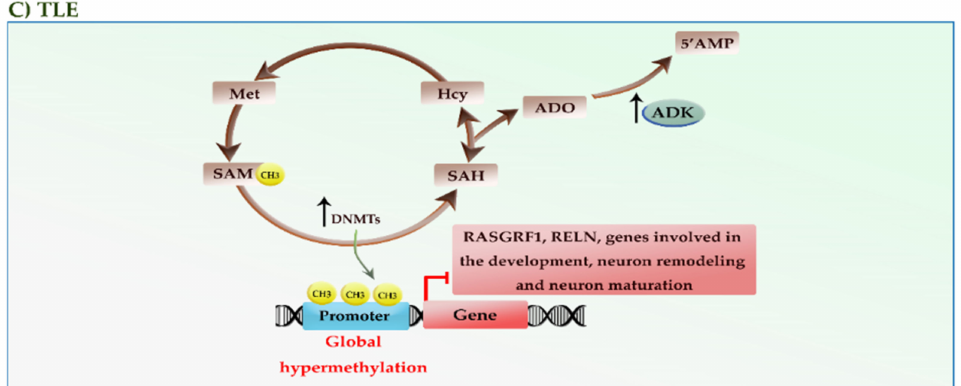
Figure 6. A schematic representation of the DNA methylation alterations in the pathogenesis of neurodevelopmental and neuropsychiatric diseases, such as ASD, SZ, and TLE. ( A ) Advanced paternal age (APA), congenital epigenetic diseases, and de novo mutations in genes encoding DNA methylation machinery may increase the susceptibility of offspring to ASD. In addition, increased MECP2 interaction with RELN and GAD1 gene promoters triggers the reduction of Reelin and GAD67 expression in the brain regions of patients with ASD. ( B ) Environmental factors and certain genetic factors (e.g., rs3749034, an SZ-risk SNP) may cause aberrant methylation and associated silencing of genes, such as RELN and GAD1 . In addition, the increased binding of MECP2 into the promoter of these genes can reduce the expression of Reelin and GAD67. Decreased GAD67 leads to reduced GABA release at synapses and compensatory regulation of postsynaptic GABA A receptors located in pyramidal neurons. ( C ) The alterations in the transmethylation pathway and adenosinergic signaling can lead to global hypermethylation of the genome in epileptogenic areas of the brain. Red colors highlighted hypermethylated genes. ADO: adenosine; AHCY: adenosylhomocysteinase; AMP: adenosine monophosphate; ADK: adenosine kinase; GAD1, 67: glutamic acid decarboxylase1,